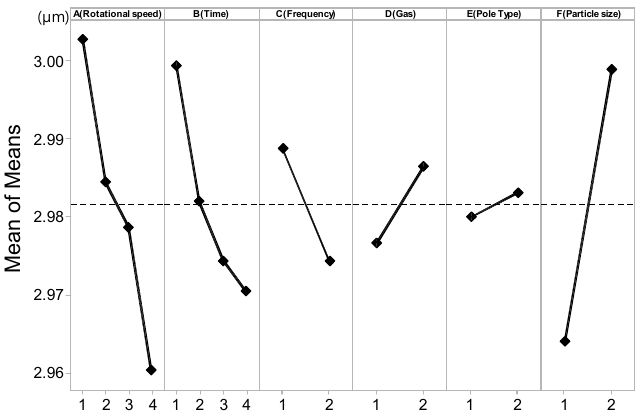
Figure 6. Main effects plot for means of machining micro-diameter.